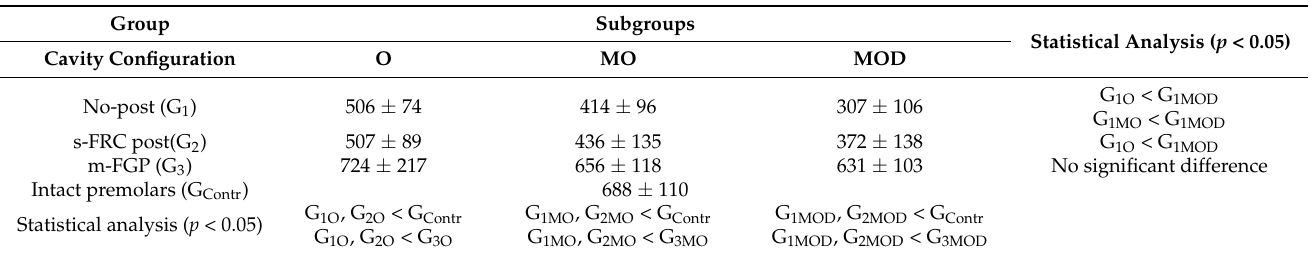
Table 1. Mean ± standard deviations of fracture load resistance and the standard deviation for experimental subgroups and G contr